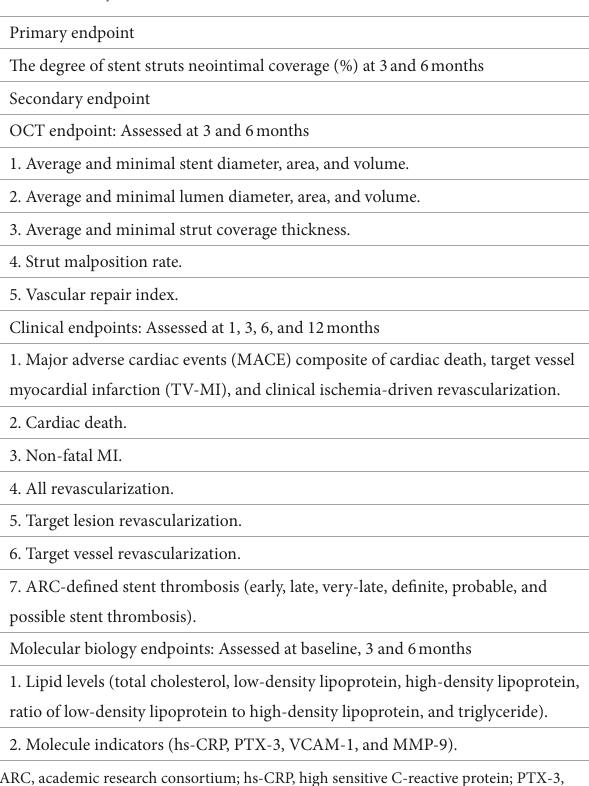
TABLE 3 Endpoints of the